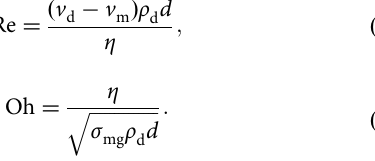
more distal to vents, for example. At these lower differential is supported, thereby coarsening the pyroclast size distribution.